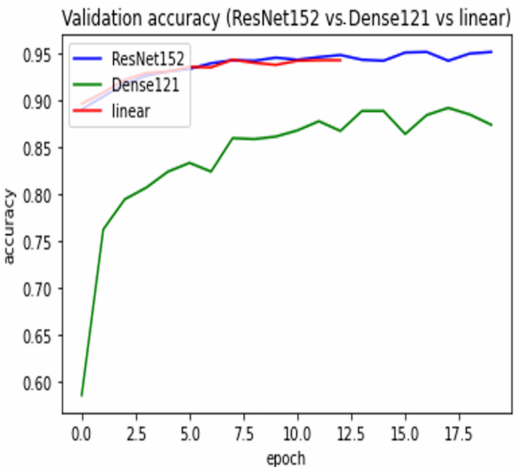
Figure 18. Training Accuracy curves for ResNet152, Dense121, and linear models.